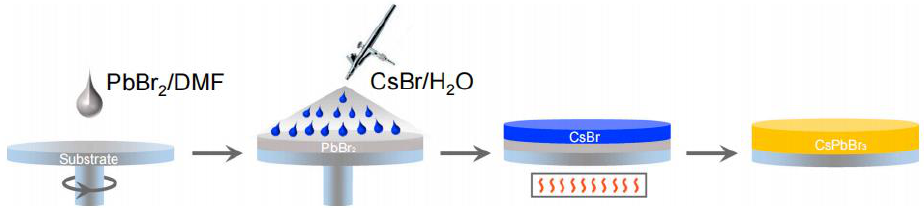
Figure 8. The photo of fabrication of CsPbBr 3 film by water-based spray-assisted growth strategy [54].